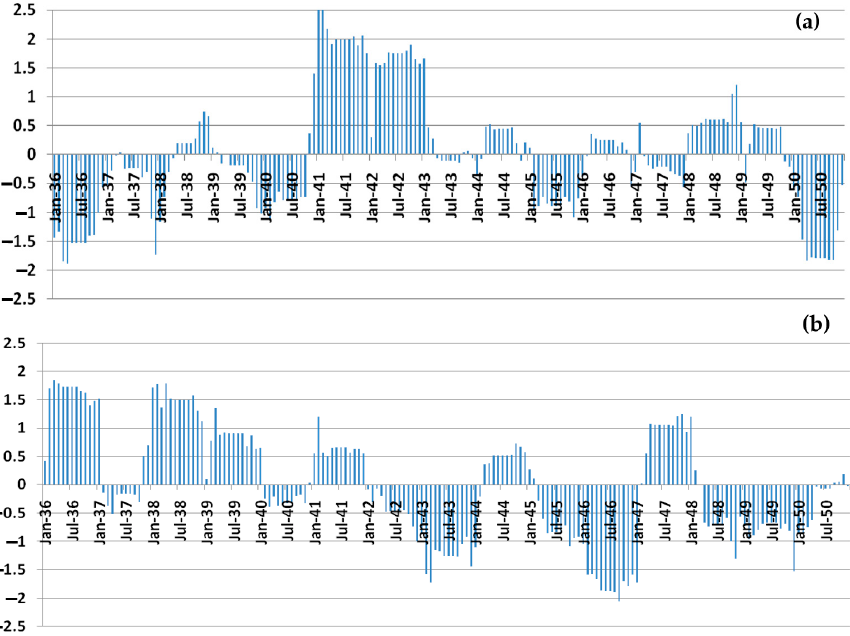
Figure 2. Monthly distribution of SPI-12 values for ( a ) 2035–2050 period under RCP4.5 and ( b ) 2035– 2050 period under RCP8.5.